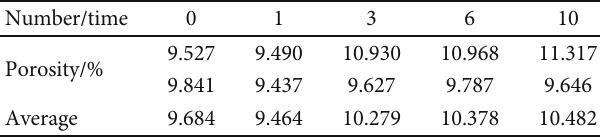
Table 1: Changes of porosity after wet and dry cycle.